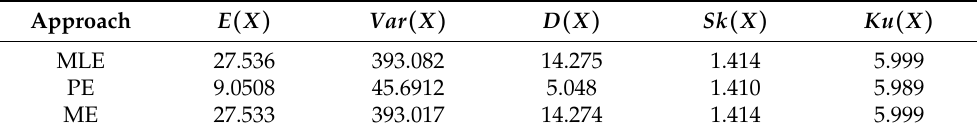
Table 9. The EDS for EC data. Table 8 . Di⁄erent estimators for EC data.